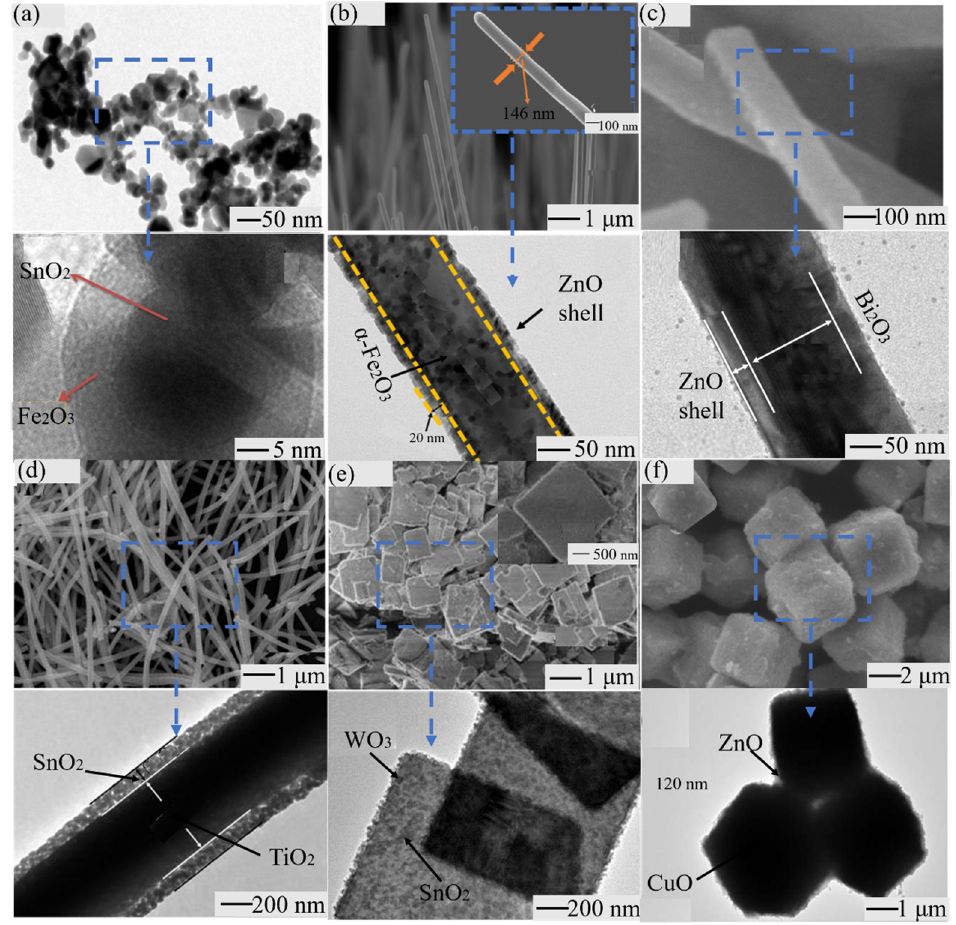
Figure 4. Typical C-S nanostructures. ( a ) C-S nanoparticles. Adapted from [75] copyright